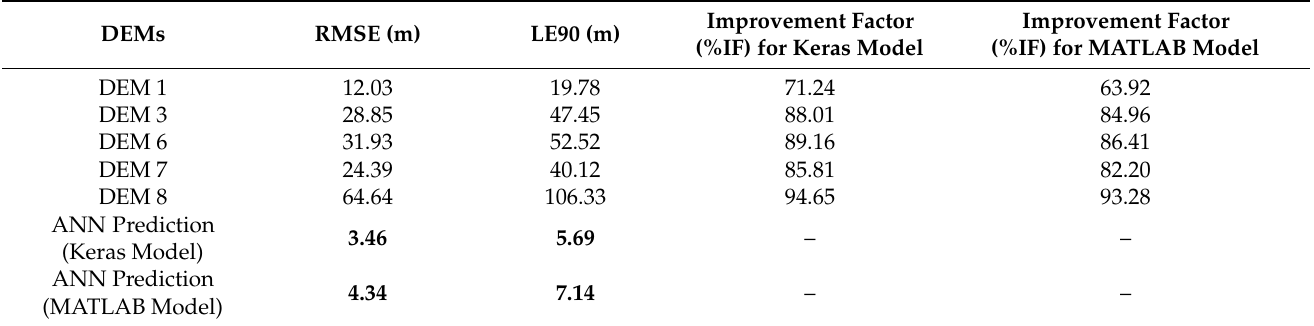
Table 3. Results for ANN fusion approach for Fused DEM assessed with TanDEM-X 90 m DEM in Ghaziabad and surrounding regions .